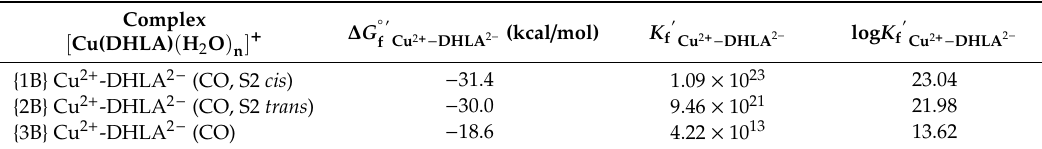
Table 6. Standard Gibbs free energy change ( ∆ G for the most stable Cu(II) complexes with DHLA 2 − re-calculated at the M06(SMD) / 6-31 ++ G(d,p) level of theory in aqueous solution under physiological pH conditions (as per Equation (14)) at 298.15 K. a